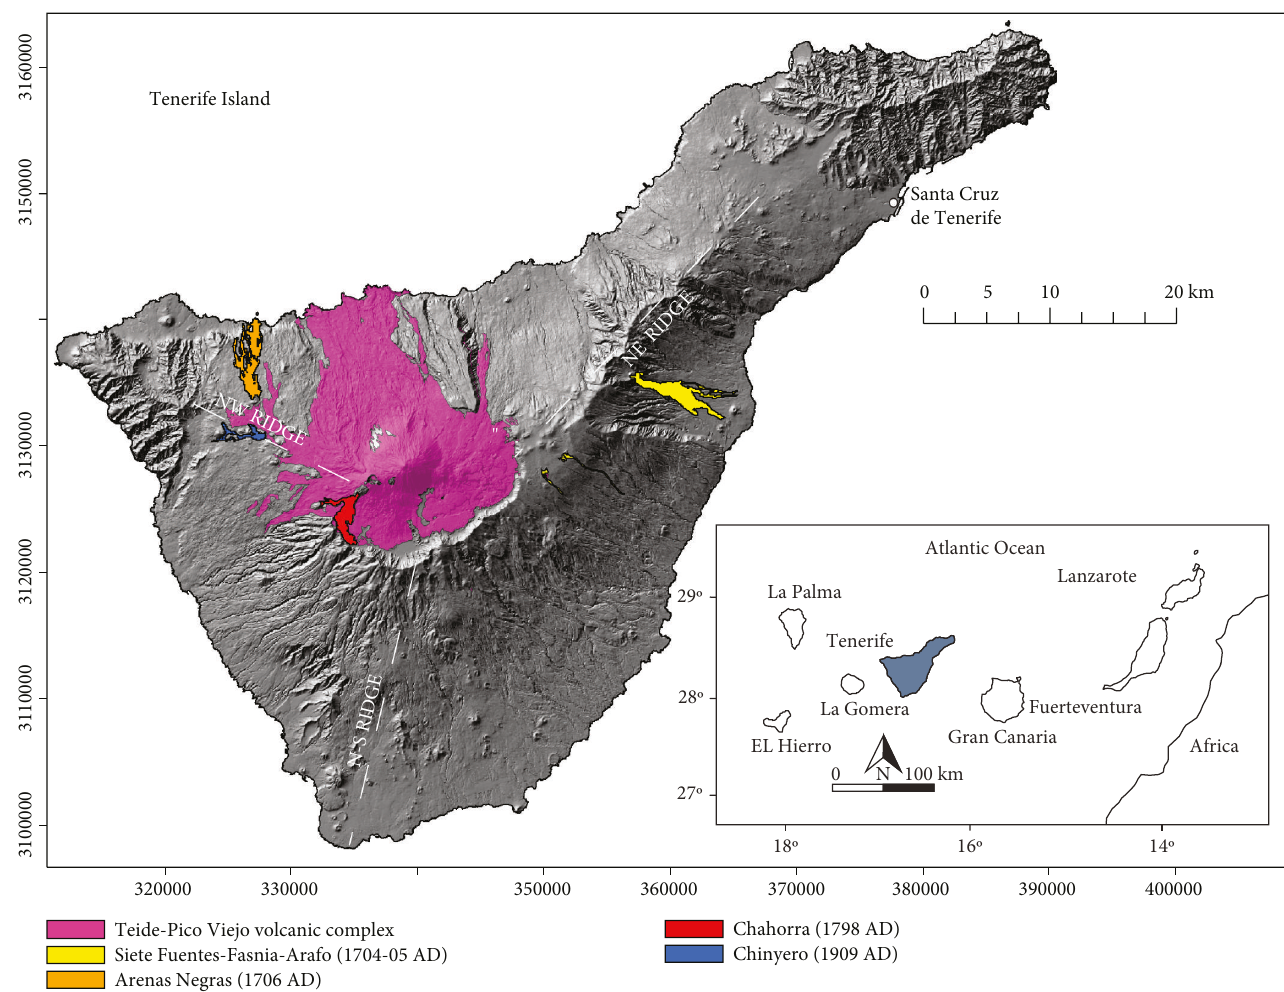
Figure 1: Tenerife Island marked with the location of the volcanic system studied, locations of historical eruptions and the three rifts. Inset: map of the Canarian archipelago highlighting Tenerife Island in